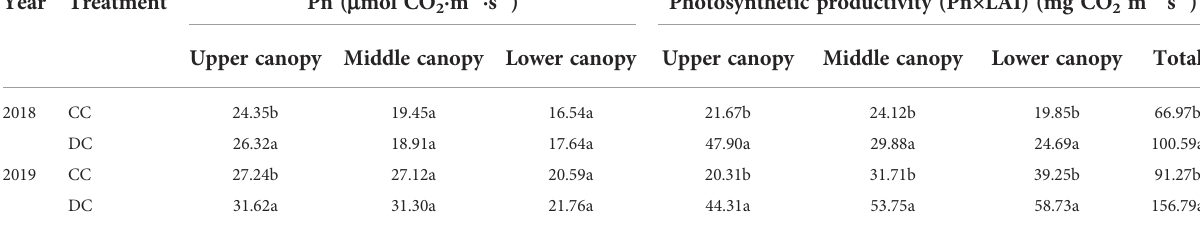
TABLE 4 Net photosynthetic rate and photosynthetic productivity in different